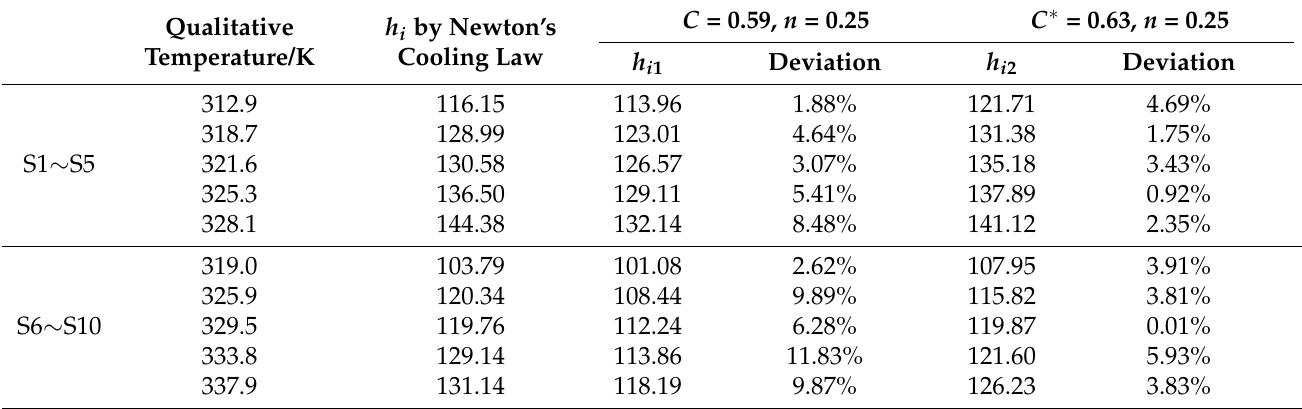
Table 3. Natural convective heat transfer coefficients calculated without and with optimized